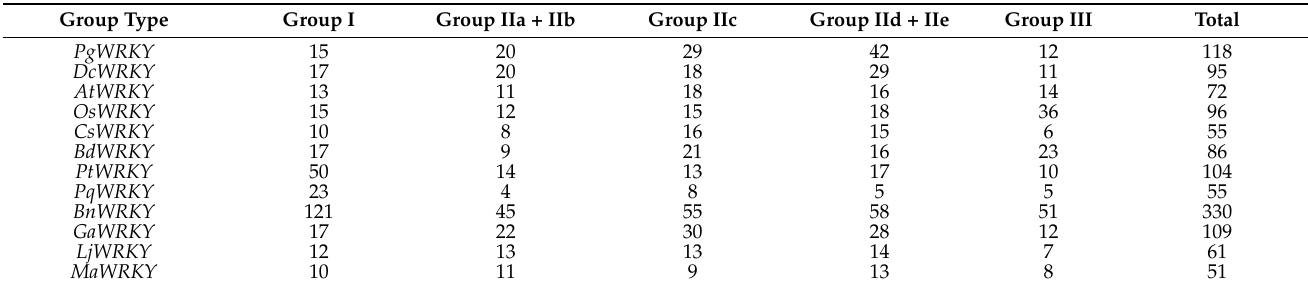
Table 1. The number of PgWRKY genes in ginseng.